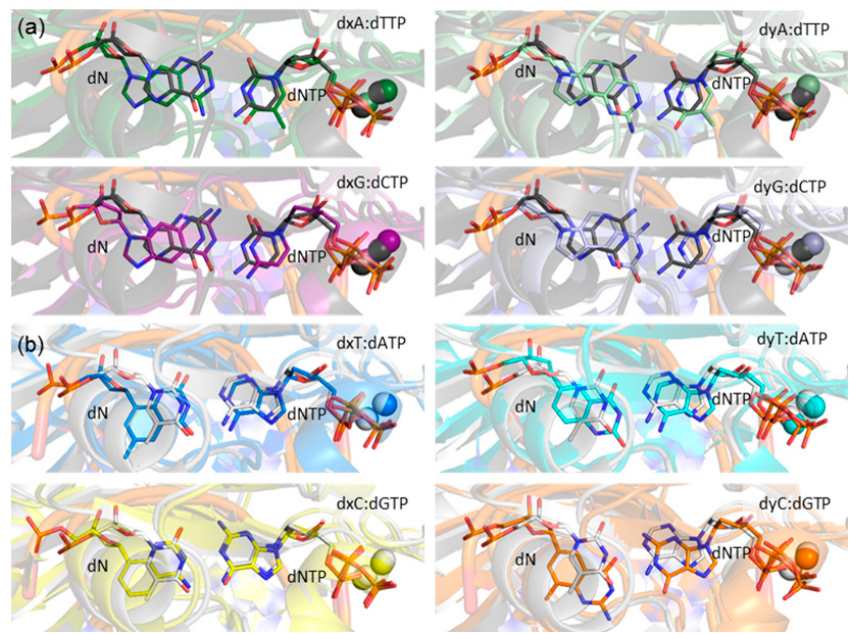
Figure 5. Overlays of representative MD structures of the (x,y)DNA base pairs with representative MD structures of the ( a ) dG:dCTP (black) or ( b ) dT:dATP (white) pair in the Dpo4 ternary complexes.